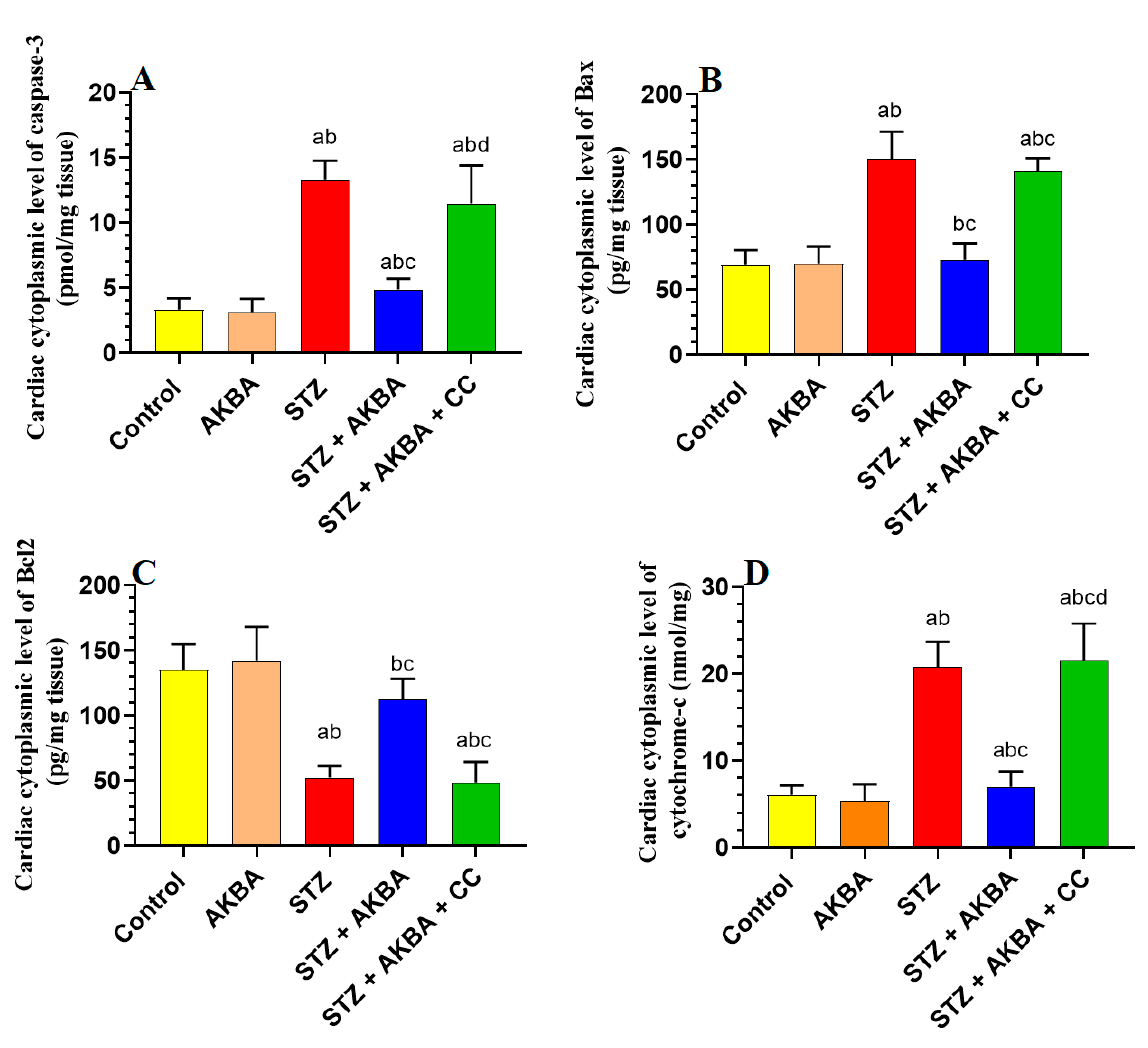
Figure 8. Cytoplasmic levels of caspase-3 ( A ), Bax ( B ), Bcl2 ( C ), and cytochrome-c ( D ) in the left ventricles (LVs) of all rat groups. Data were analyzed with one-way ANOVA followed by Tukey’s test. Values are presented as mean ± SD (n = 8/group). Data were considered significantly different at p < 0.5. a: significantly different as compared to control rats; b: significantly different as compared to AKBA-treated rats; c: significantly different as compared to STZ-diabetic rats; d: significantly different as compared to STZ + AKBA-treated rats. CC–compound C (a selective AMPK inhibitor).